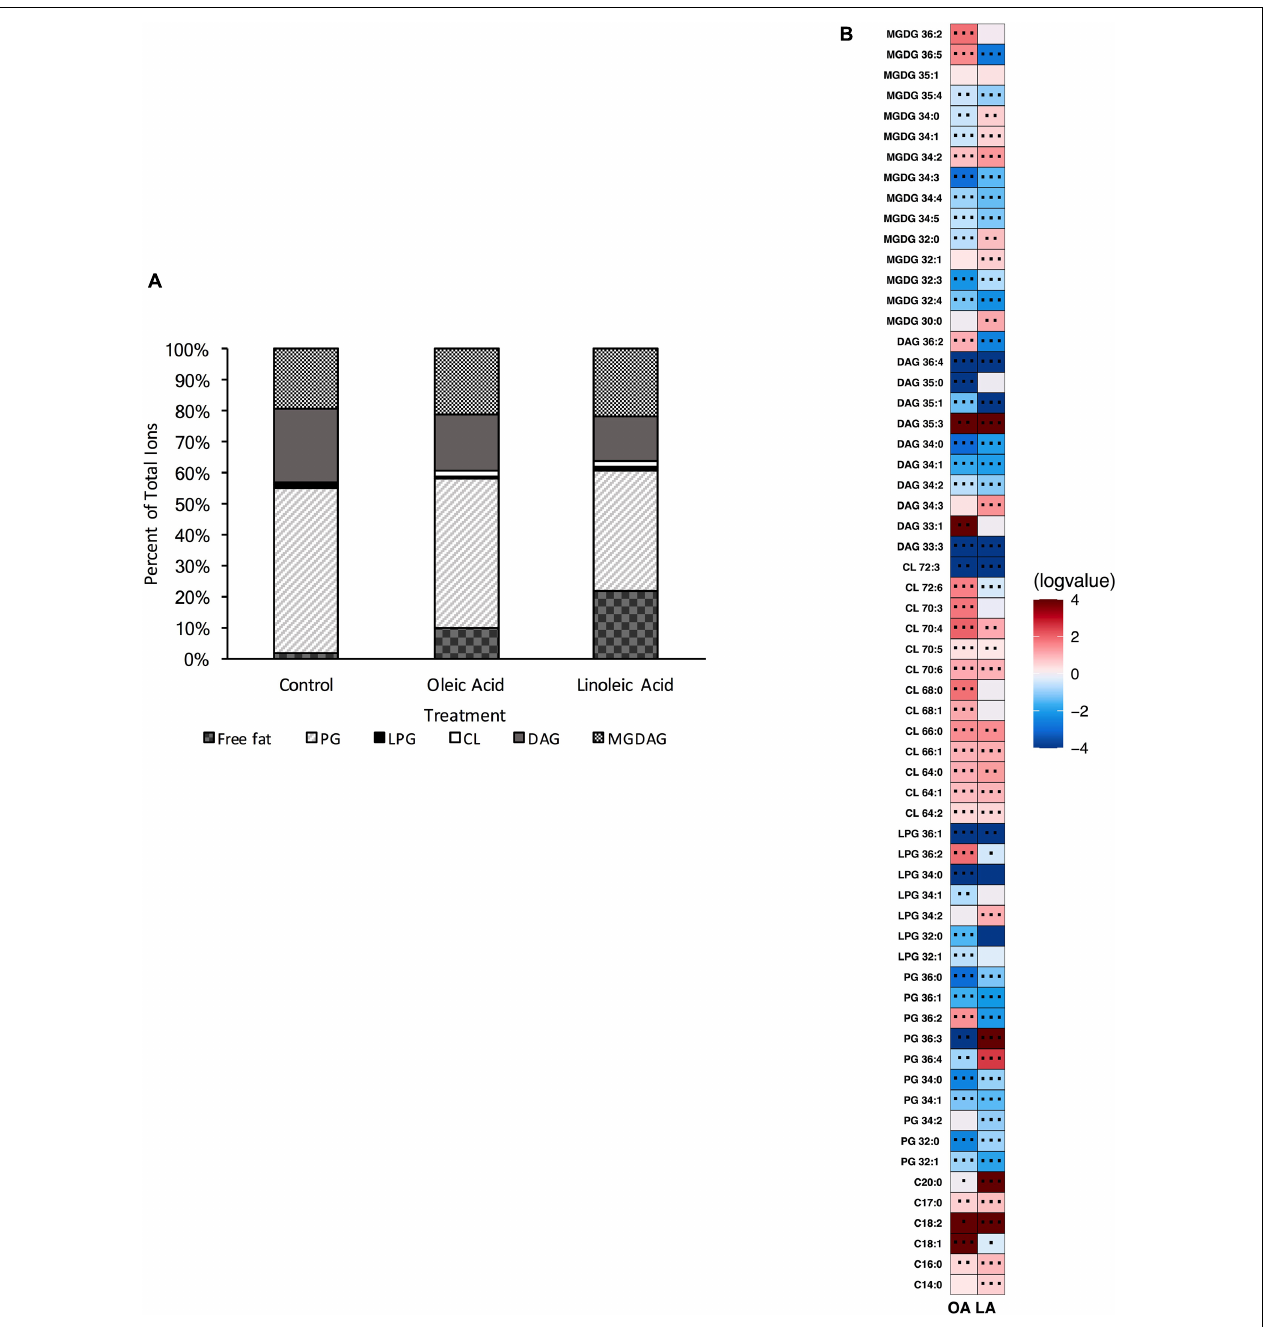
FIGURE 2 | OG1RF lacking (cid:49) cls1 can still produce cardiolipin and alter its lipid composition upon exposure to host fatty acids. (A) Percent totals of lipid species for (cid:49) cls1 in solvent control: free fatty acids (2.0%), PG (53.5%), L-PG (0.7%), CL (0.7%), DAG (23.8%), and MGDG (19.4%), oleic acid: free fatty acids (9.8%), PG (48.3%), L-PG (0.7%), CL 2.0%), DAG (17.9%), and MGDG (21.3%), linoleic acid: free fatty acids (22.1%), PG (38.9%), L-PG (1.2%), CL (1.8%), DAG (14.7%), and MGDG (21.4%). Species were normalized to OD 600 nm . (B) Heat-map of fold changes upon fatty acid supplementation vs. solvent control for (cid:49) cls1 ; OA, oleic acid supplementation; LA, linoleic acid supplementation. Shown are the average fold changes of those detected lipid species above limit of detection for n = 5 samples. * P = 0.1–0.05; ** P = 0.05–0.01; *** P < 0.01.